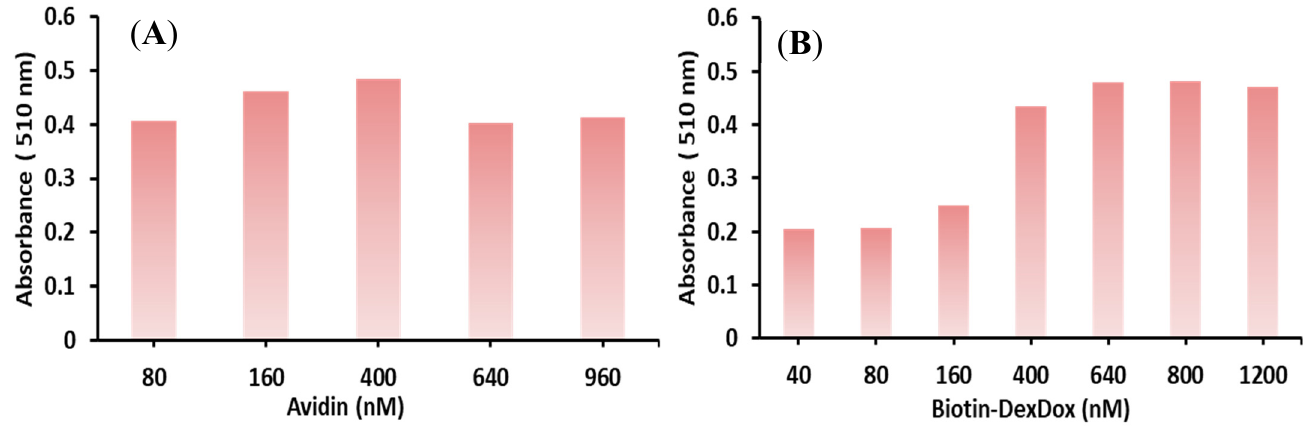
Figure 9. The effect of added ( A ) avidin concentration and ( B ) Biotin-DexDox on the determination of the well-fixed biotinylated antibody using the biotin–avidin interaction.